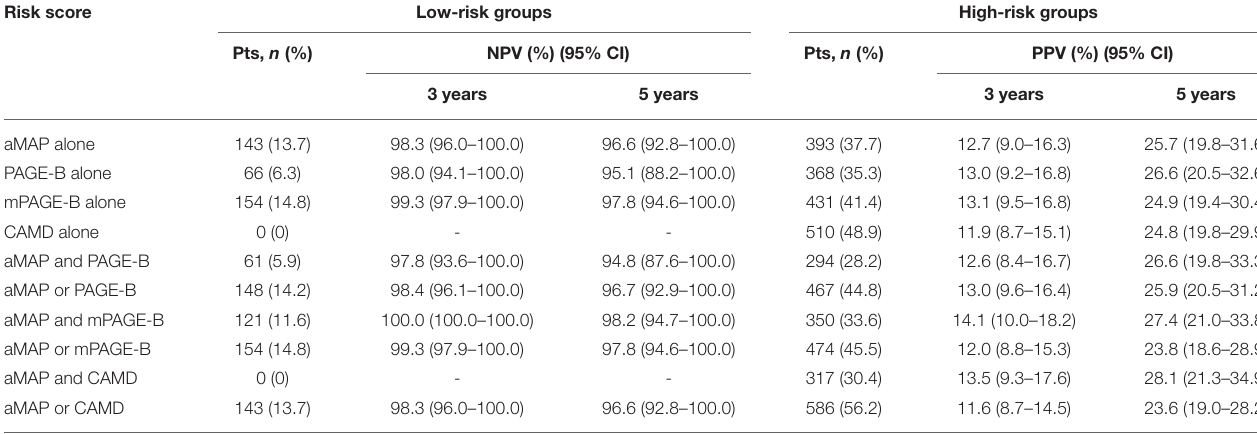
FIGURE 2 | Cumulative probability of development of HCC according to risk stratification by the aMAP score. TABLE 4 | Diagnostic accuracy on HCC development in 3 and 5 years by low- and high-risk cut-off of aMAP and other risk